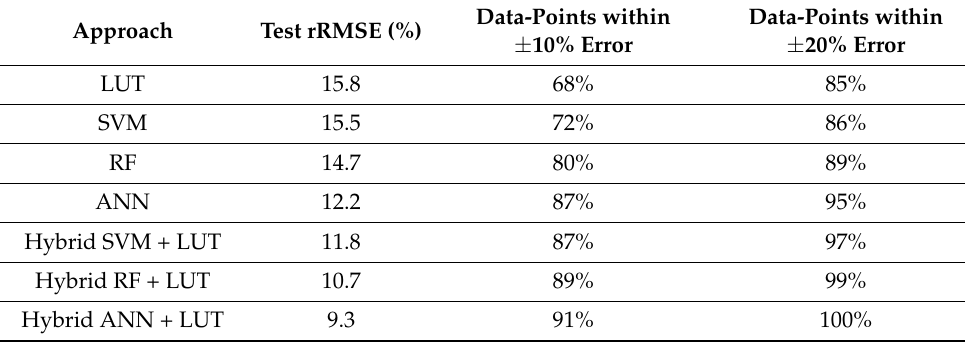
Table 3. Different CHF models’